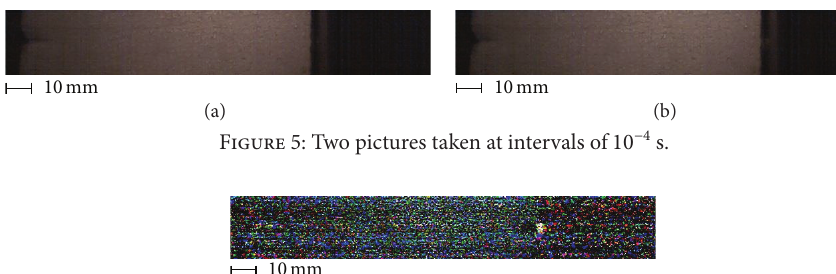
Figure 6: 30 times sharpening of the differential chart.